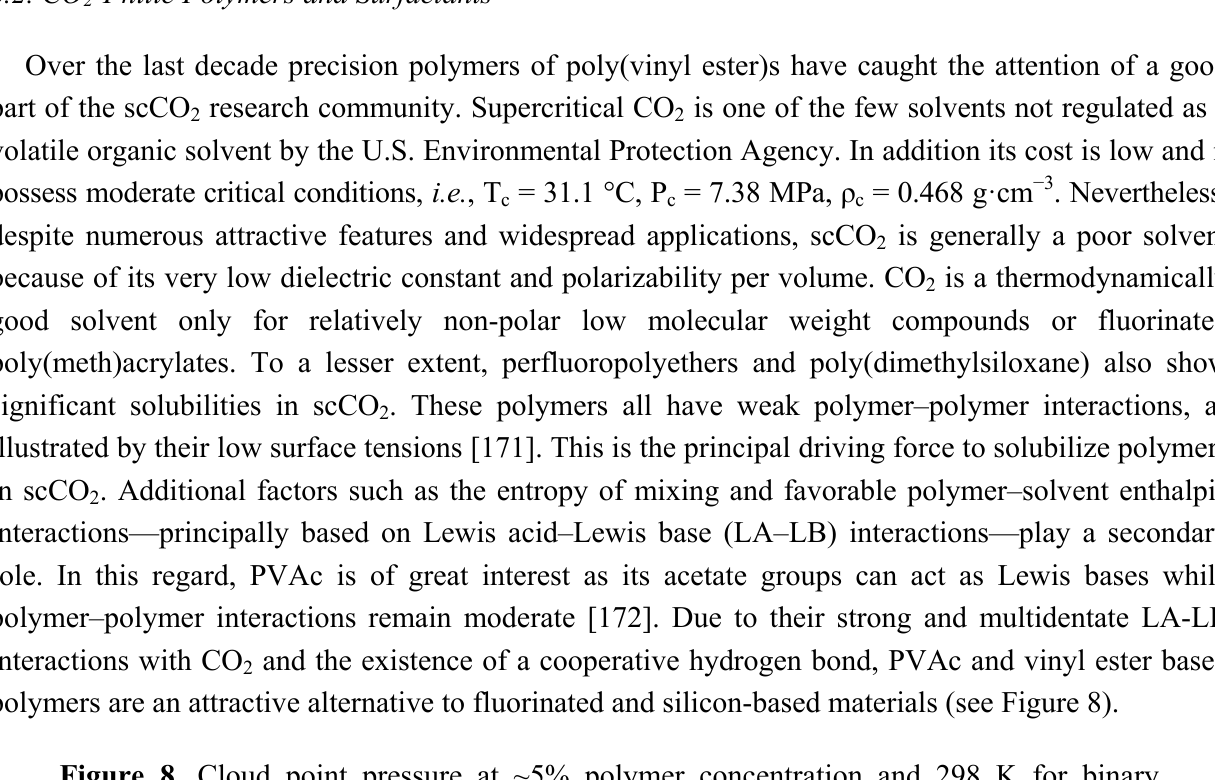
Figure 8. Cloud point pressure at ~5% polymer concentration and 298 K for binary with PMA, poly(lactide) (PLA), PVAc, poly(dimethyl siloxane) (PDMS), mixtures of CO 2 and poly(fluoroalkyl acrylate) (PFA) as a function of number of repeat units based on M Reproduced with permission from reference